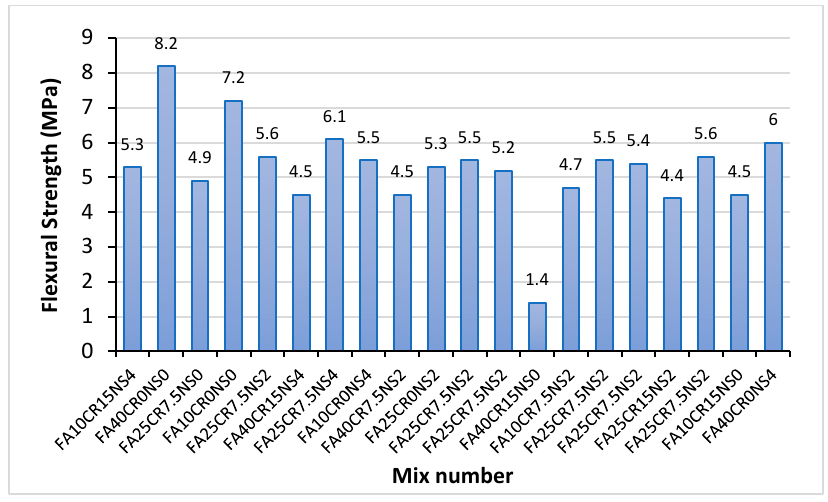
Figure 8. Flexural strength result at 20 days.